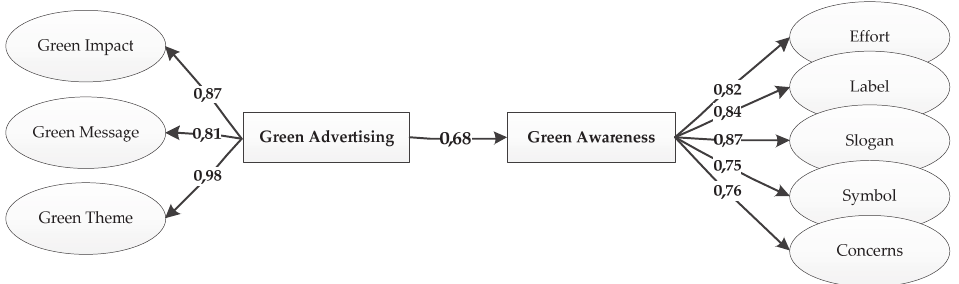
Fig. 4. Correlation Value of Green Advertising and Green